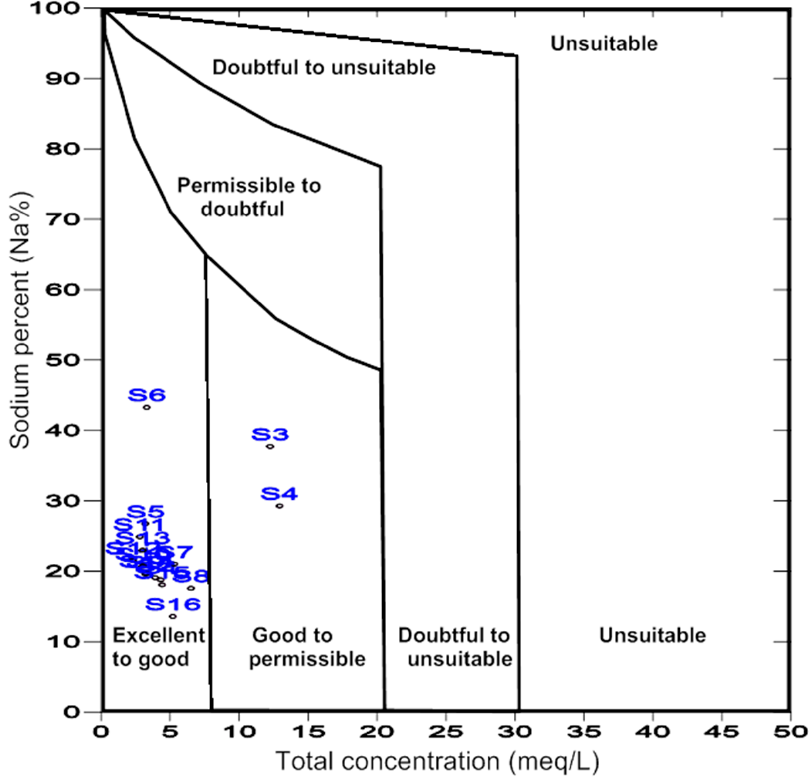
Figure 5. Classification of water for irrigation use in the study area (after Wilcox [47]).